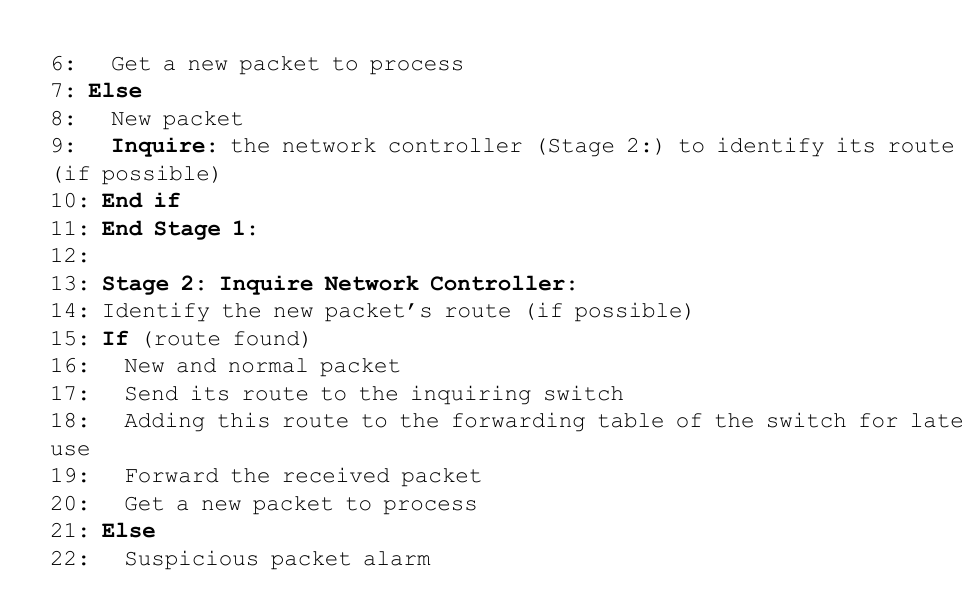
Suspicious packet alarm